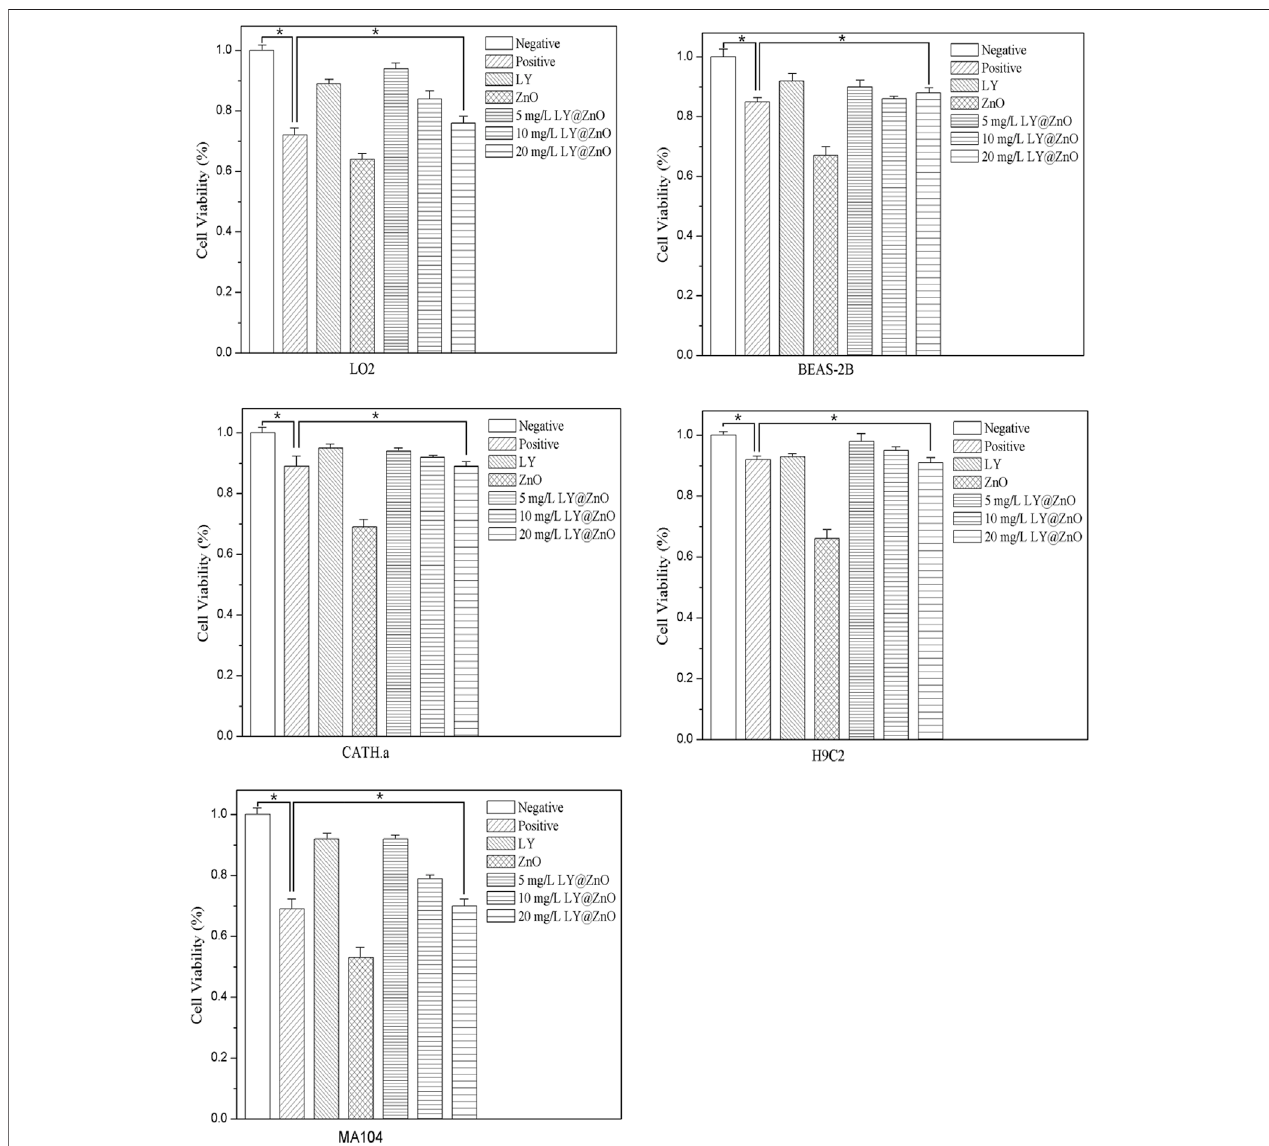
FIGURE 15 | Tissue section of the lung, liver, spleen, kidney, and heart with 20.0 mg/L LY@ZnO processed.